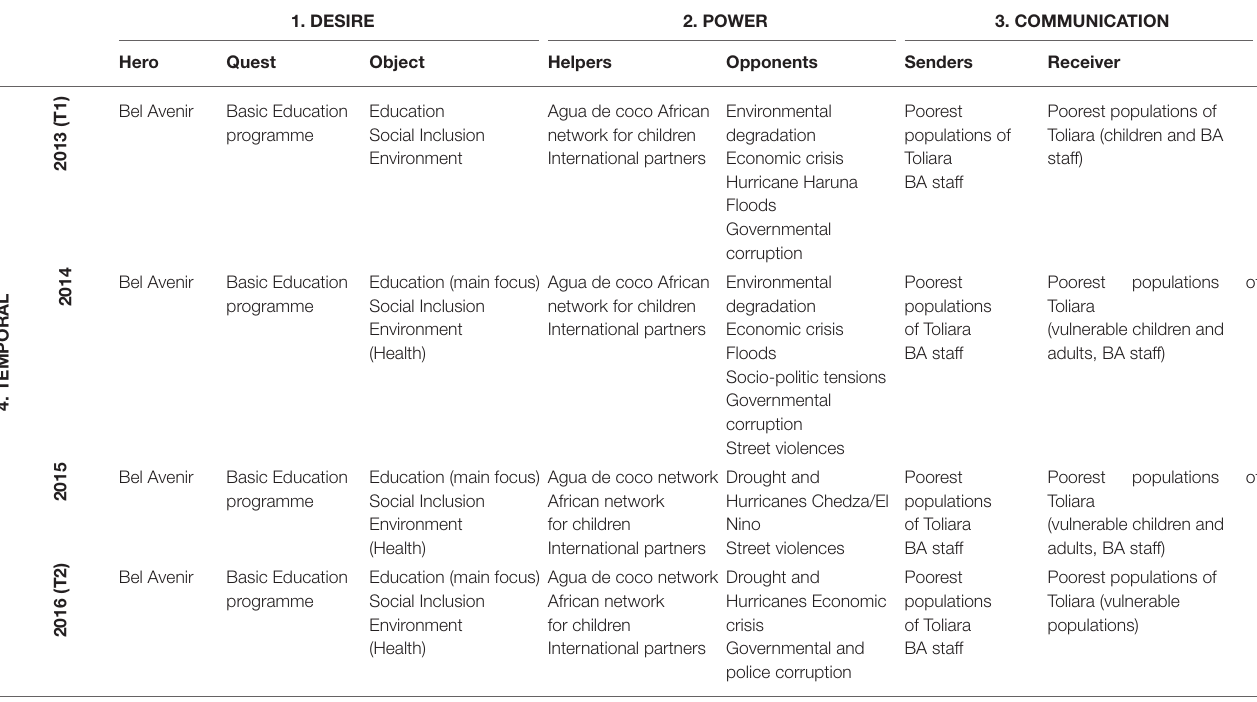
TABLE 1 | Evolution of the NGO over 4 years. 1. DESIRE 2.